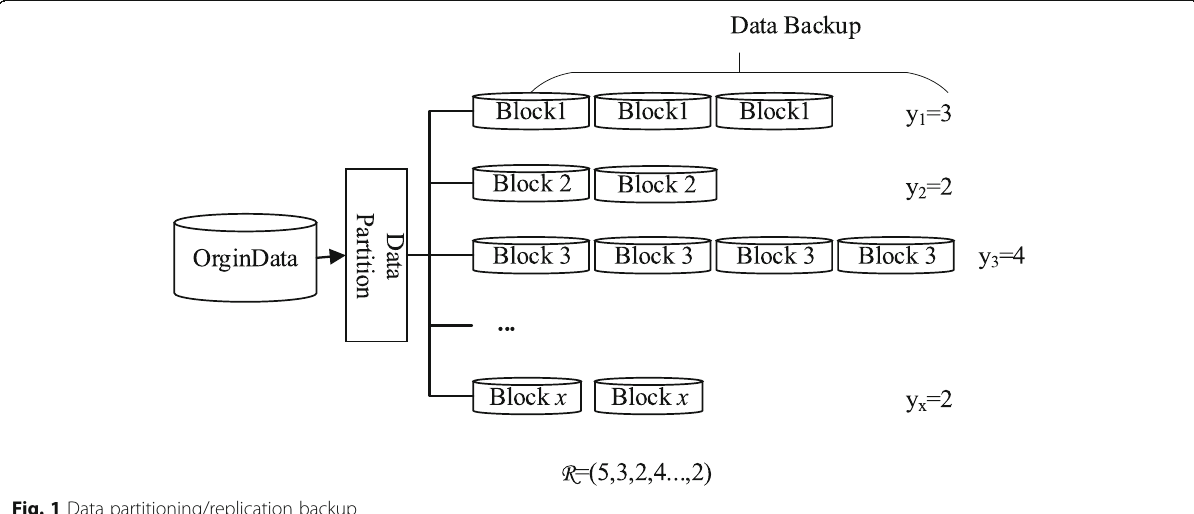
Fig. 1 Data partitioning/replication